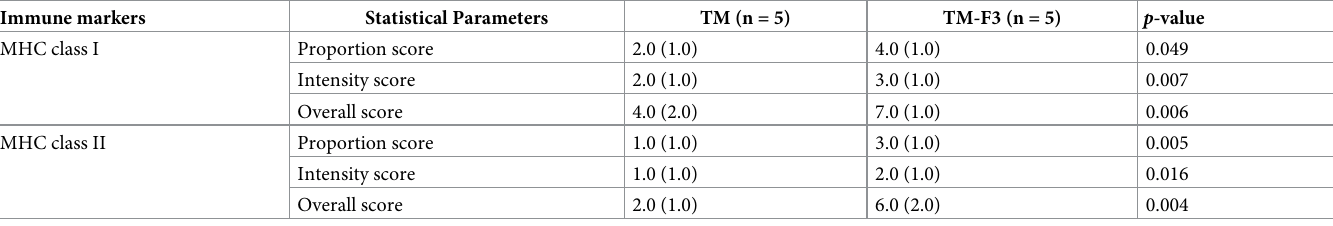
P values were calculated using Mann-Whitney test for comparison between untreated (TM) and F3-treated (TM-F3) groups. Results are presented as median values with IQR in brackets, and p < 0.05 is considered statistically significant.